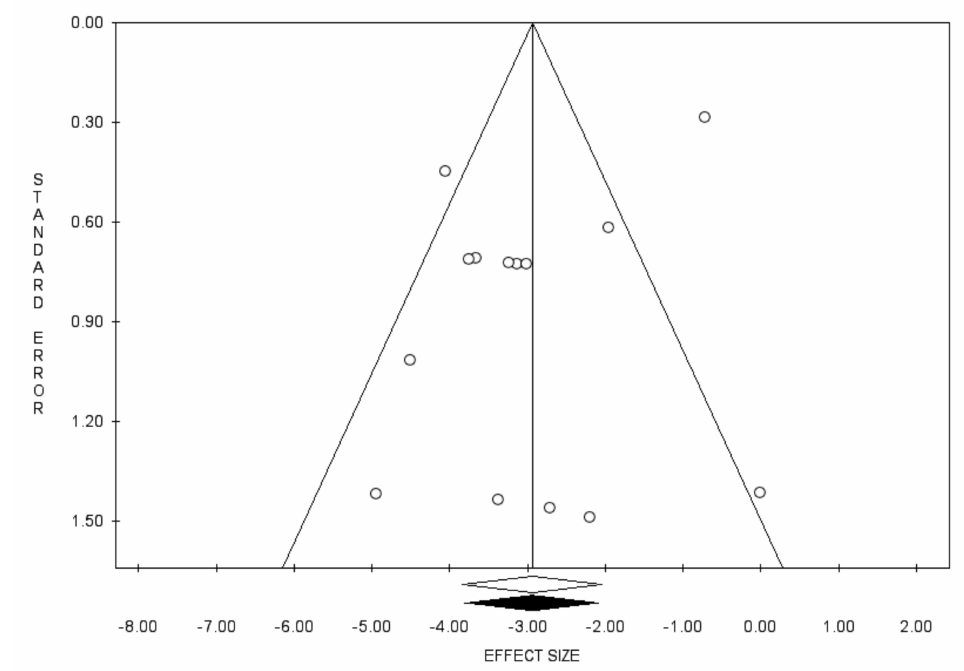
Figure 9. Funnel plot for the prevalence of non-response rate after the completion (fifth and sixth dose) of the second vaccination cycle.